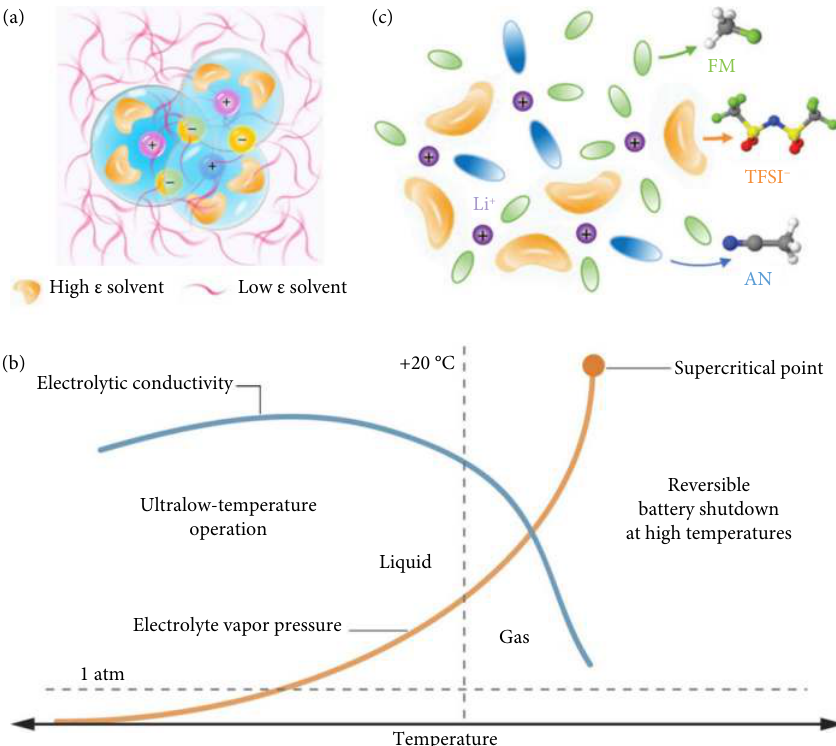
Fig. 4 Designing electrolytes with optimized solvation structure to render a low desolvation barrier and high ionic conductivity at low temperatures. (a) The interactions between Li ions and solvents in fluorinated electrolytes with non-polar solvents (reprinted with permission from Ref. [74], © The Author(s), under ex- clusive licence to Springer Nature Limited 2019). ( b ) Variation of electrolytic conductivity and pressure with temperature of liquefied gas electrolytes (reprinted with permission from Ref. [76], © 2017 The American Association for the Advancement of Science ). ( c ) The solvation structure of liquefied gas electrolytes (reprinted with permission from Ref. [77], © The Royal Society of Chemistry 2020).